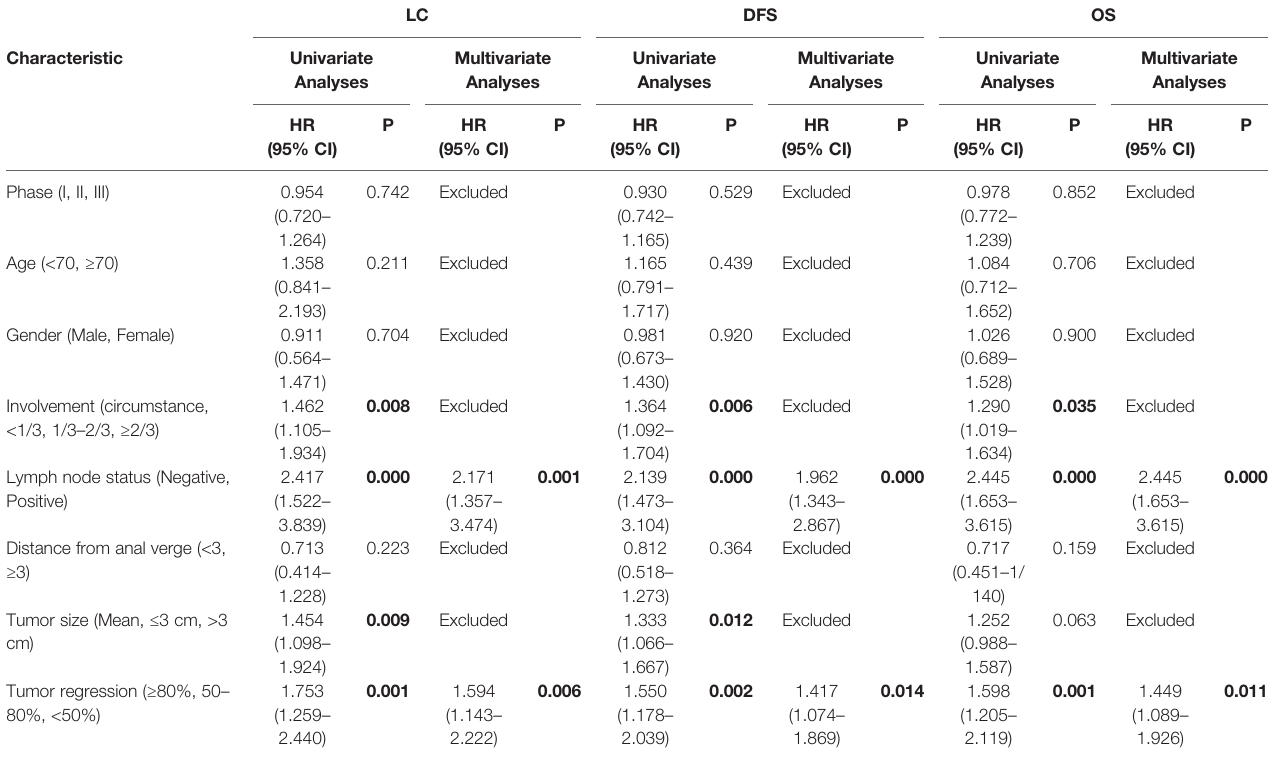
TABLE 4 | Univariate and multivariate analyses of factors associated with LC, DFS, and OS for T3 rectal cancer patients, respectively.